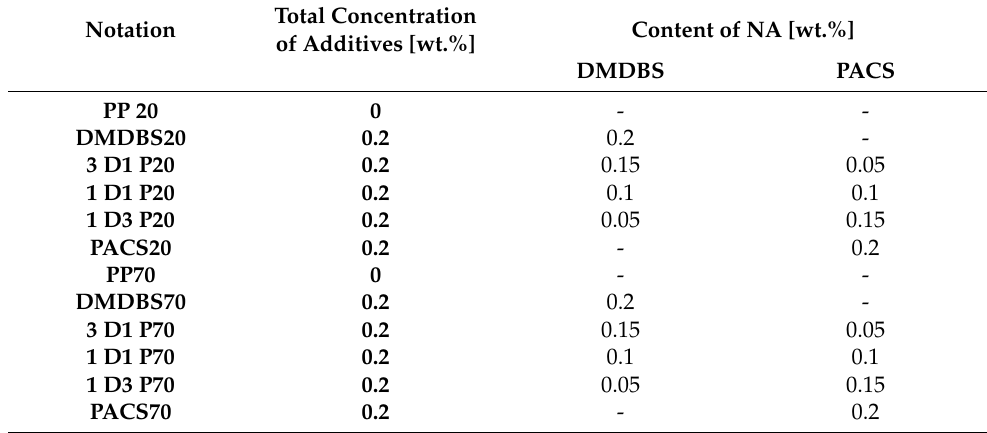
Table 2. Composition of iPP nucleated samples. 20 and 70 ◦ C correspond to injection mold